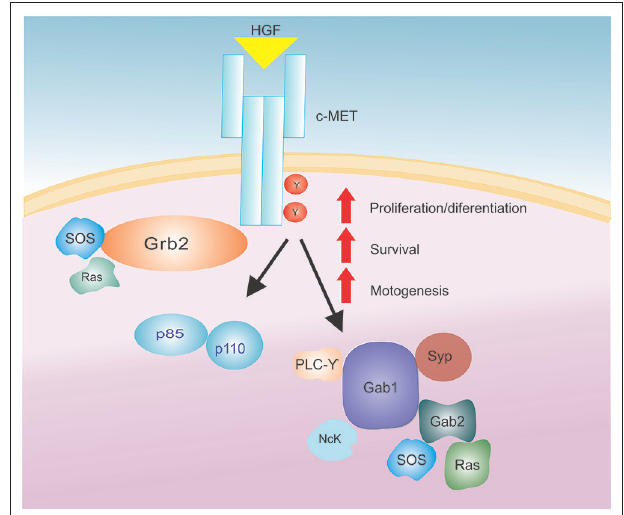
FIGURE 1 | The HGF/c-Met signaling axis. After HGF binding to the c-Met receptor there is an activation of a signaling cascade that increases several biological actions (proliferation/differentiation, survival and